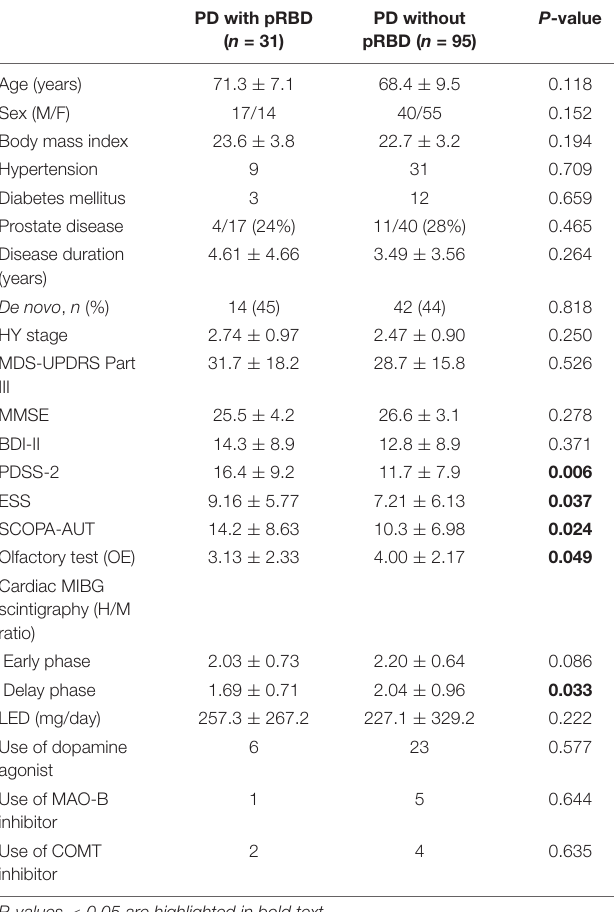
TABLE 1 | Comparison of clinical variables between PD patients with pRBD and PD patients without pRBD.